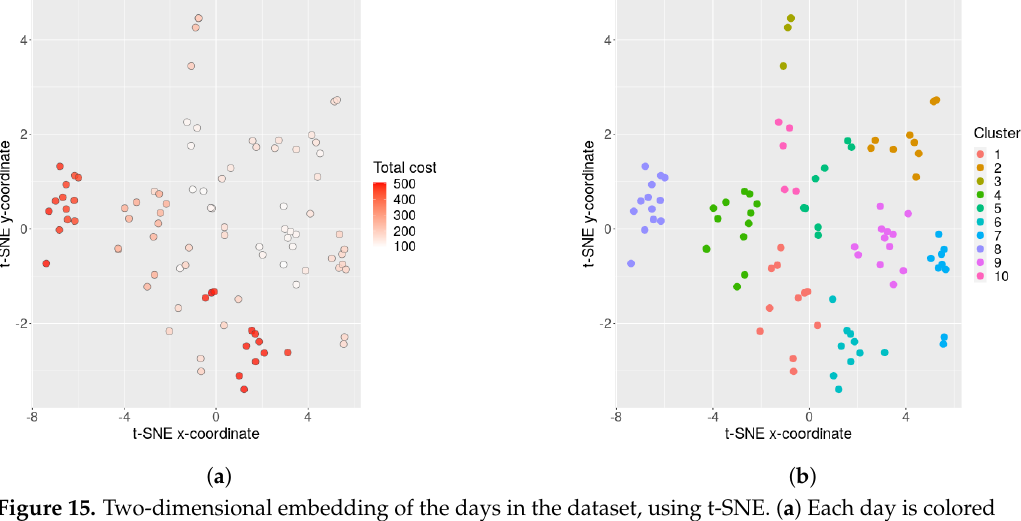
Figure 15. Two-dimensional embedding of the days in the dataset, using t-SNE. ( a ) Each day is colored according to the total cost (deviation from reference values). We can see areas of high cost (red, left and bottom), as well as areas of low cost (white, right). ( b ) Each day is colored according to its assigned cluster, using k -means clustering. Each cluster can be characterized by the average cost of its